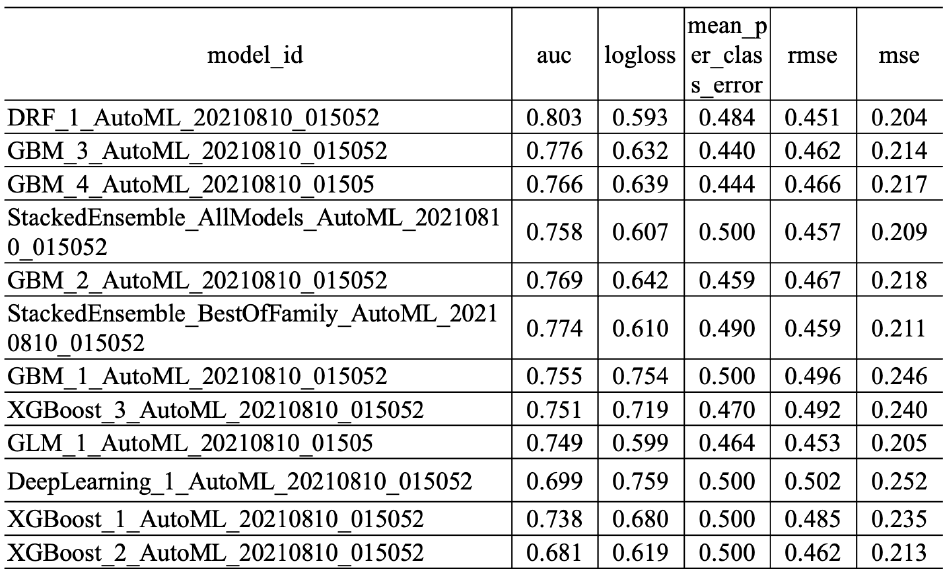
Figure 7. Results of training through automated machine learning (AutoML). “auc” is related to the accuracy results of classification produced by the trained model, and “logloss” is that the cross- entropy between the model and the target values. “rmse” is the root-mean-square error metric, and “mse” is the mean square error. “mean_per_class_error” is one kind of available options for classification.